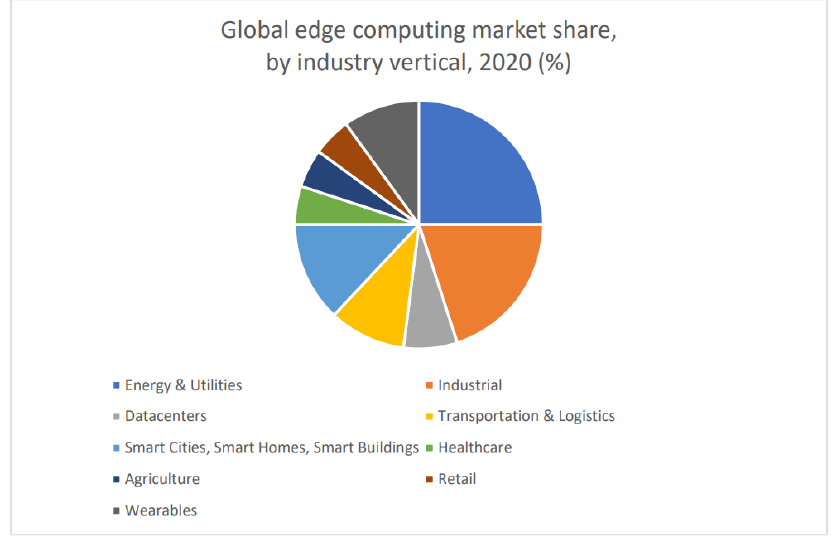
Figure 3. Global edge computing market share by industry vertical, as of 2020